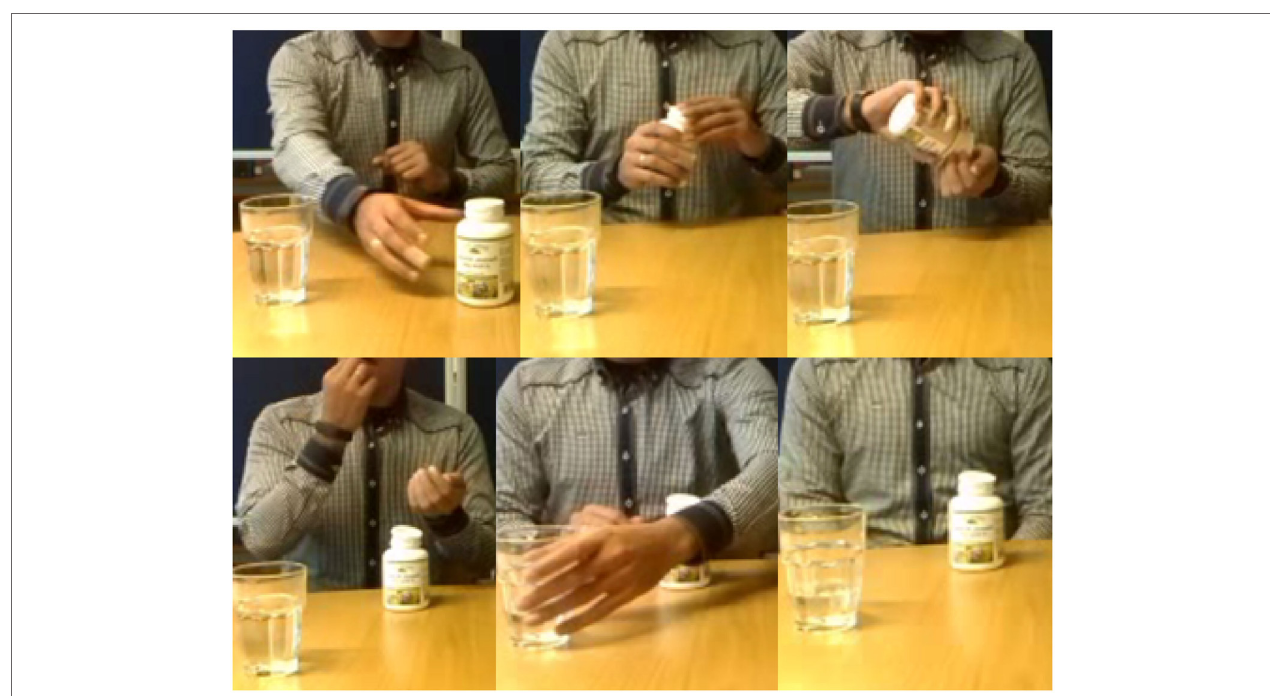
FigUre 15 | An example of the complexity of medicine intake. The participant raises his left arm from his lap to allow him to reach forward while picking up the bottle with his right hand, opens the bottle with a spherical grip using the left hand, extracts a pill onto his left hand, replaces the bottle on the table and takes the medicine with the right hand to the mouth, reaches out for the water with his left hand while pushing down on the table with his right wrist, replaces the bottle and returns both hands to his lap. As a result of this action, the medicine bottle is in a new location and not fully closed.